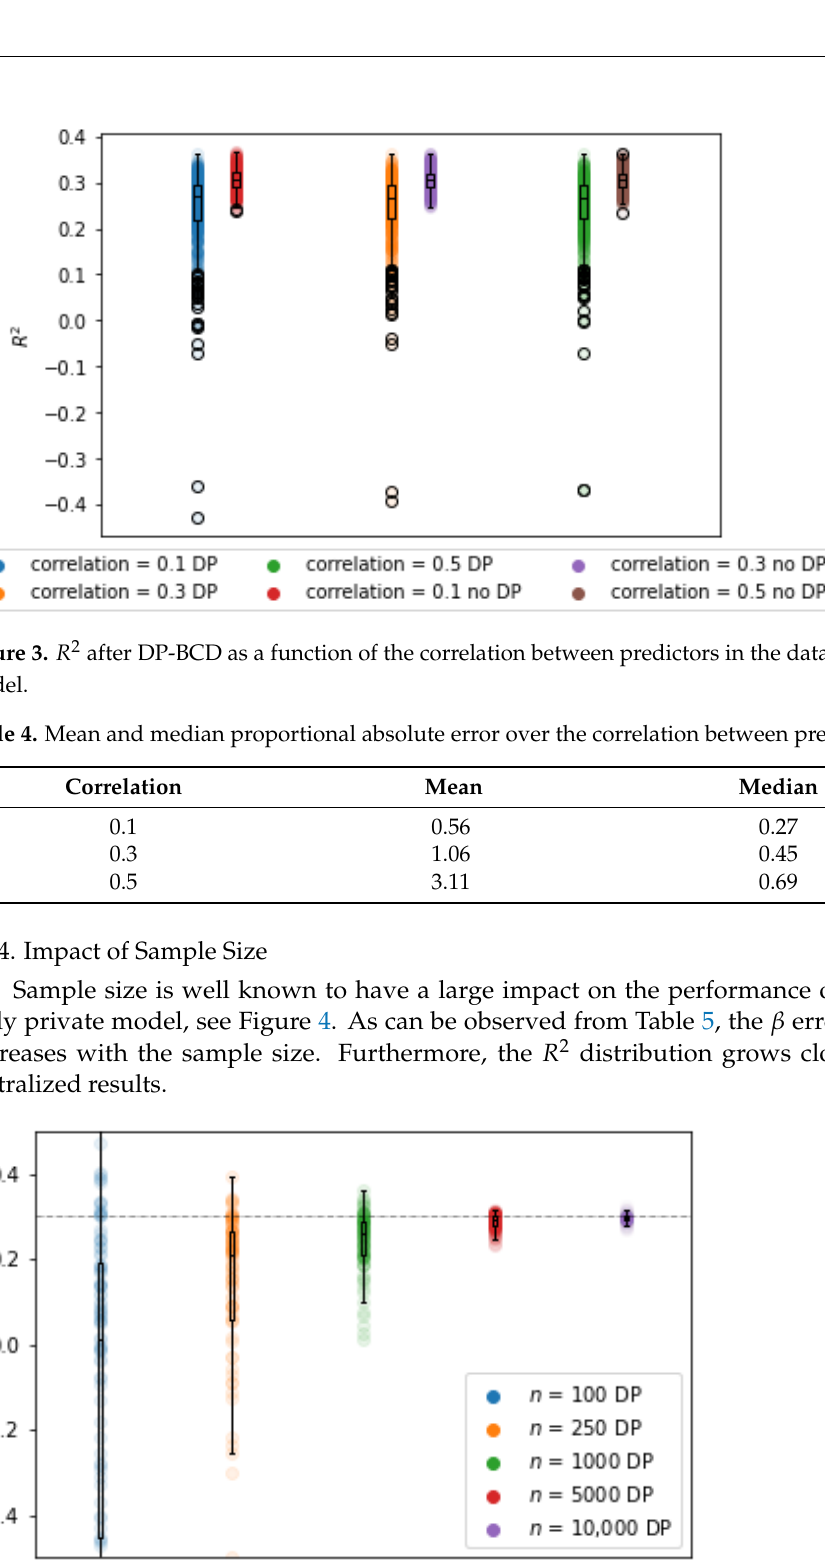
Figure 4. R 2 after DP-BCD as a function of N